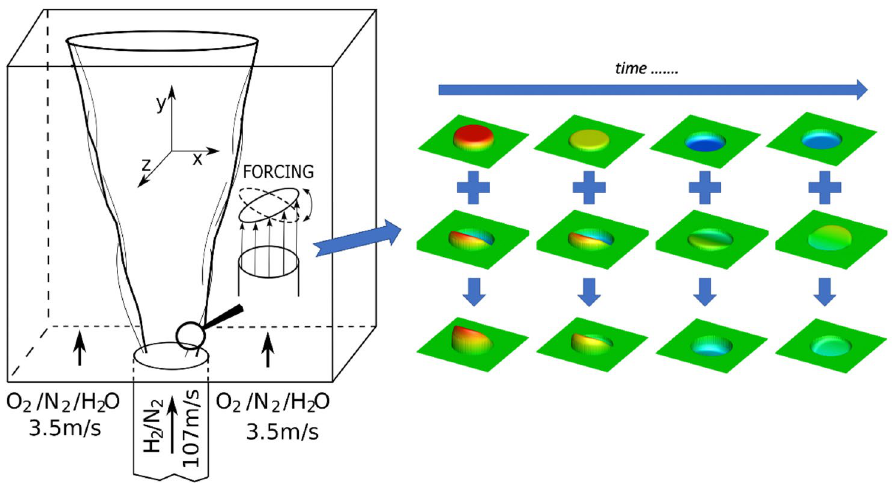
Figure 1. Schematic view of the computational domain with the axial velocity iso-surface showing the time evolution of the axial and flapping